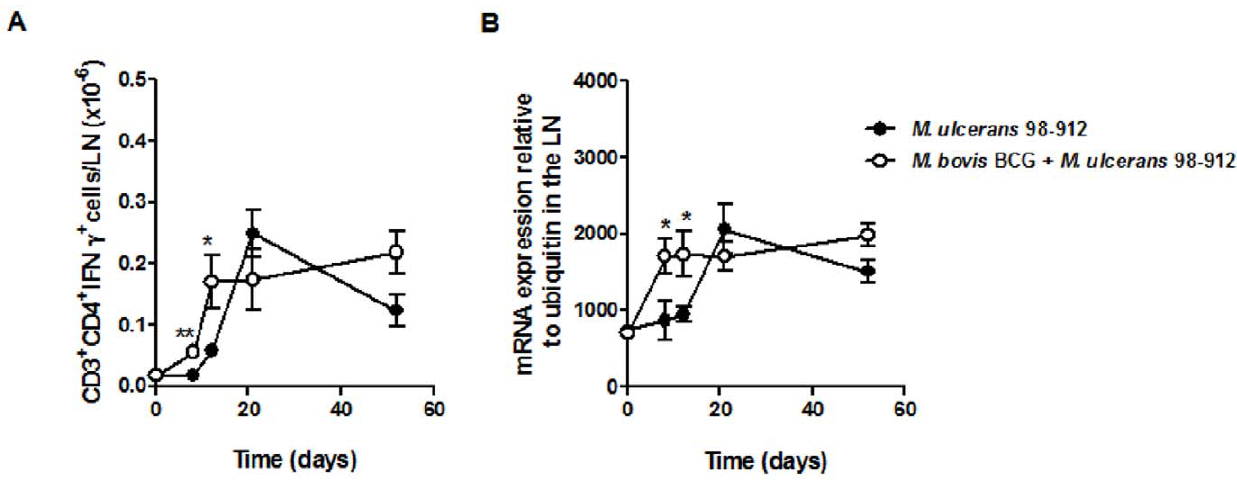
N Figure 4. Vaccination with BCG induces an early IFN- c response in the DLN of M.ulcerans -infected mice. Mice were either non- ) or immunized with BCG ( # ) two months before challenge. All mice were infected in the footpad with 4 log 10 CFU of M. ulcerans 98– immunized ( 912. (A) At different time points post-infection, the total number of CD3 + CD4 + IFN- c + in the DLN of the infected footpad was determined by flow cytometry. The data points represent the mean 6 SEM ( n =5–8). (B) At different times post-infection, total RNA from the popliteal lymph node was extracted and the presence of mRNA for IFN- c was assessed by real-time PCR. Data points represent the mean 6 SEM ( n =5–8) for each time point. Statistical significance was calculated with Student’s t test (* p , 0.05). Statistical significance was calculated with Student’s t test (* p , 0.05; ** p , 0.01).